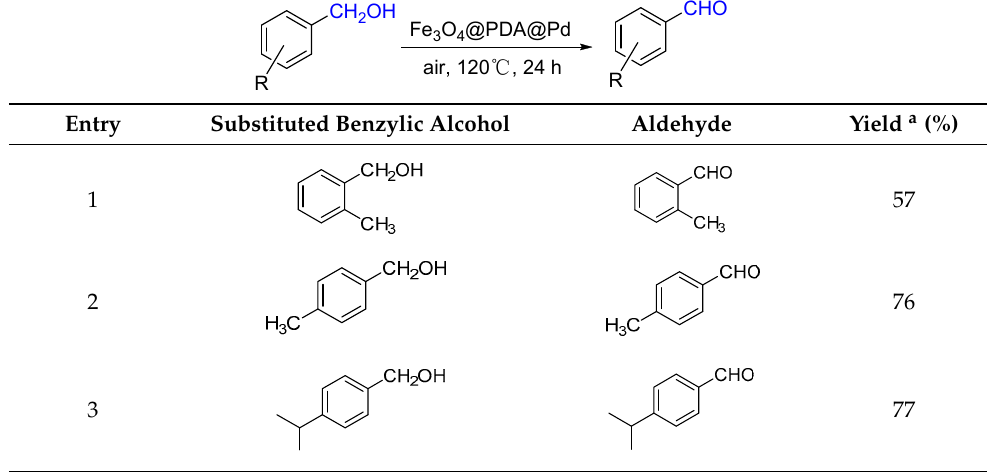
Table 3. Catalytic dehydrogenation of substituted benzylic alcohols to aldehydes.